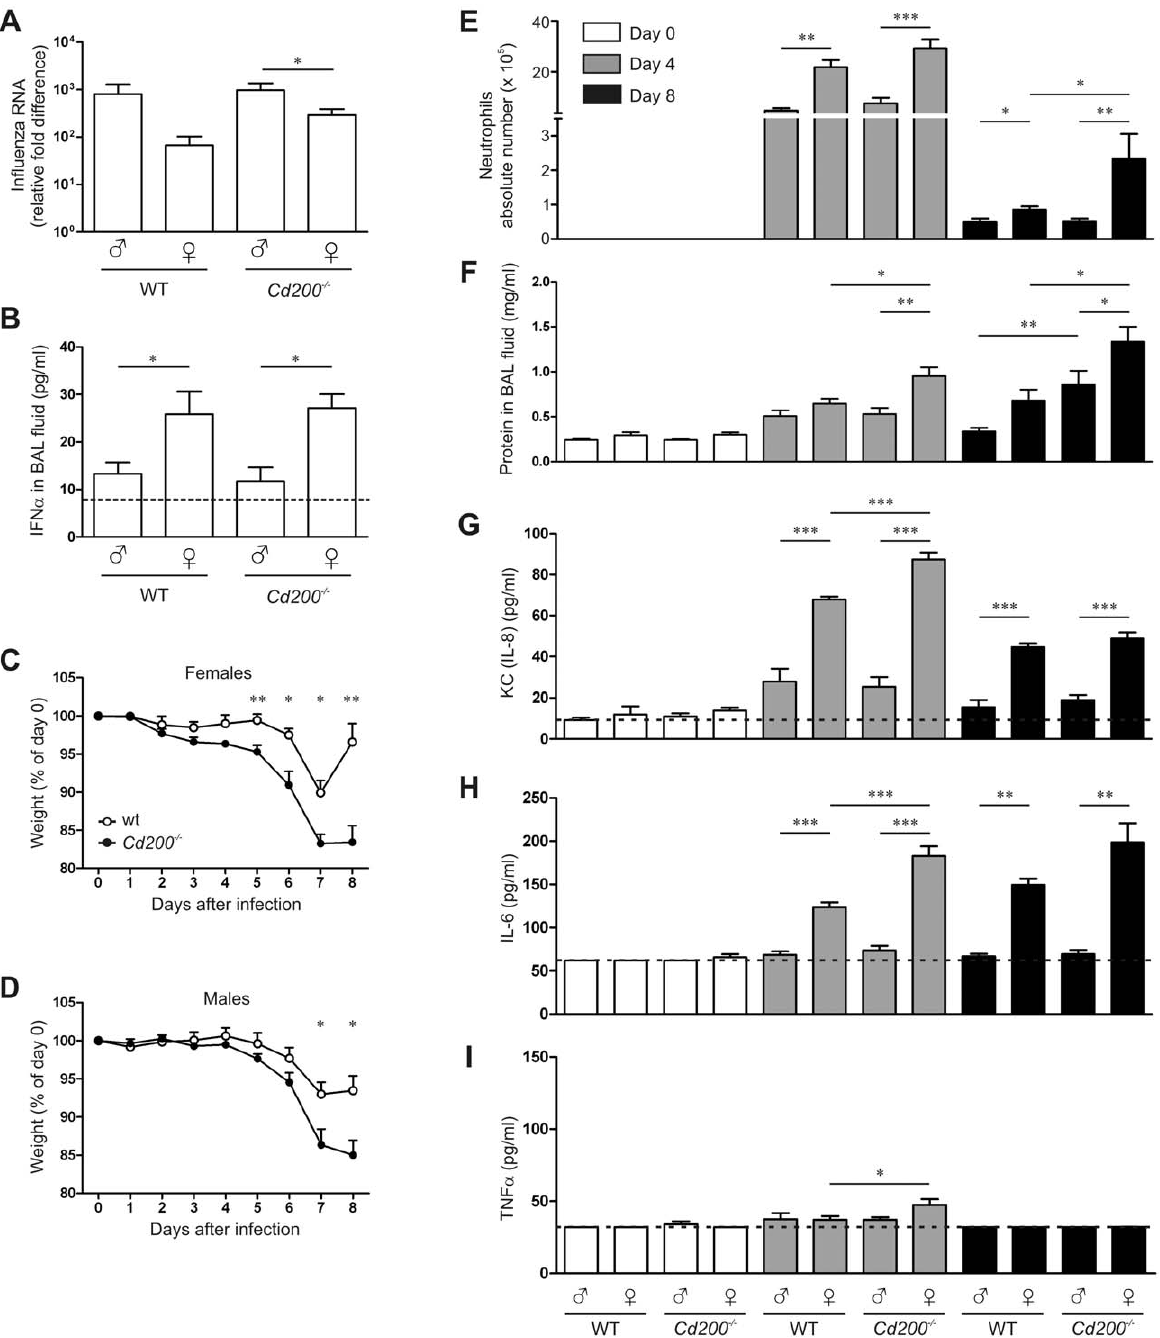
Figure 4. CD200-deficiency and sex determine the outcome of influenza A virus infection. Naı¨ve or influenza A virus-infected mice were sampled at indicated time points. A Relative amounts of viral RNA in the lungs were determined by qRT-PCR. B IFN a concentration in the BAL fluid was determined by ELISA. The dotted line indicates the detection limit. C, D Body weight of infected female ( C ) and male ( D ) Cd200 2 / 2 mice (filled symbols) and WT mice (open symbols) as percentage of the weight at day of infection. E Quantification of neutrophil numbers in BAL fluid by differential cell count. F Quantification of the total protein content in BAL fluid. Concentrations of KC (IL-8) ( G ), IL-6 ( H ) and TNF a ( I ) in the BAL fluid were measured by ELISA. In all panels mean 6 SEM is shown, statistical significance was calculated with Mann-Whitney test. *=p , 0.05, **=p , 0.01. cence signals were acquired with PhotoVision software (Biospace were positioned to the ventral side in a specially designed box and Laboratory) over a 10-min interval and are expressed as integrated placed onto the stage inside the light-tight photon imager light intensity (photons/min). A low-intensity visible light image (Biospace Laboratory). Five mice were imaged simultaneously was generated and used to create overlay (heatmap) images for exactly 5 min after the injection of D-luciferin. The biolumines- each individual animal.